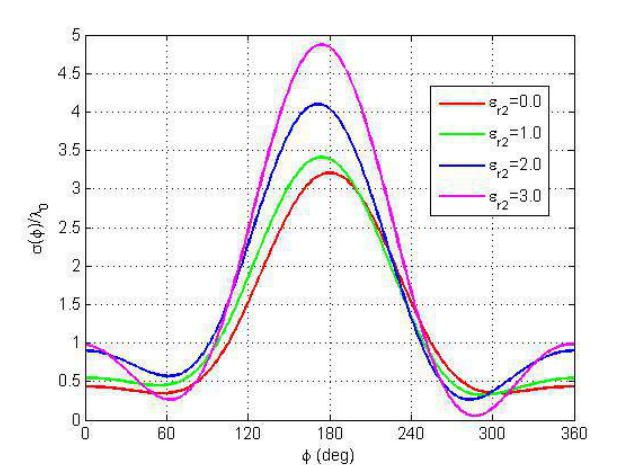
Figure 6: Normalized bistatic width versus scattering angle, when a G-type elliptic cylinder with an axial ratio of 2, 𝑘 ! 𝑎 = 0.4𝜋 , as well as 𝜀 !! = 4 , 𝜇 !! = 2, and 𝜀 !! = 0, 1, 2, 3 , is excited by a plane wave of TE polarization incident at 0 !